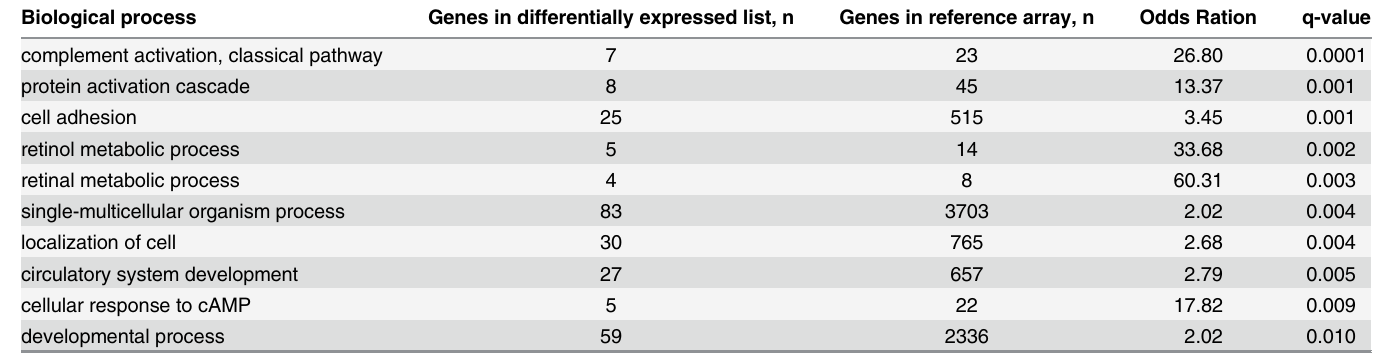
Table 6. A list of the 10 enriched biological processes in the comparison between visceral and subcutaneous adipose tissues of non-pregnant women. Biological process